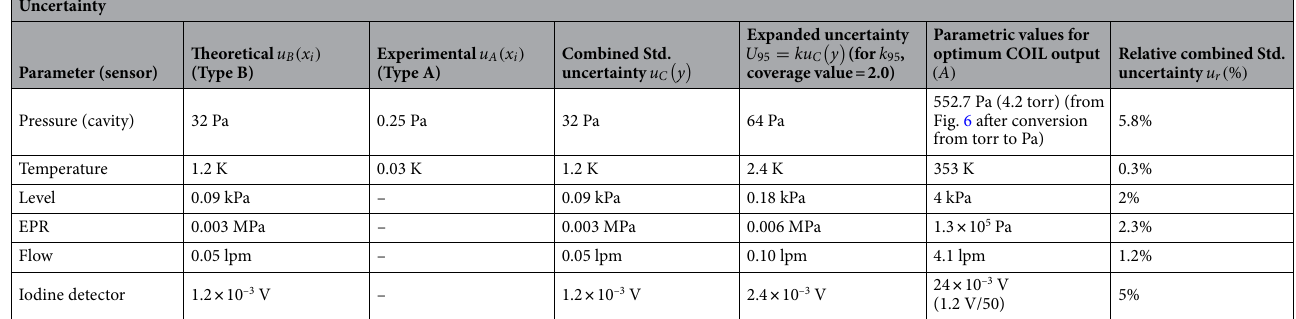
Table 6. Expanded and relative uncertainty relevant to